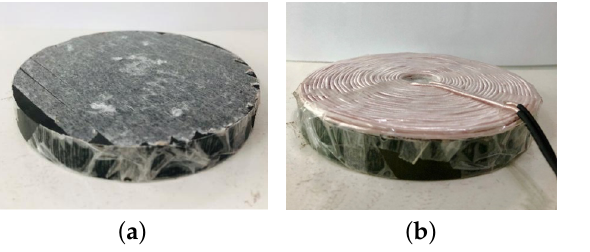
Figure 11. Prototype of planar core: ( a ) Prototype of the single planar core; ( b ) Prototype of the planar core with